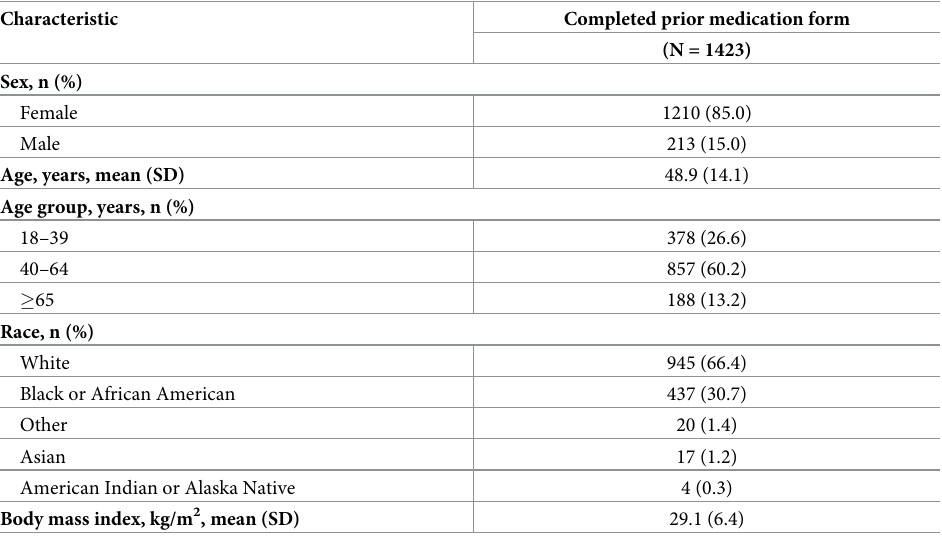
Abbreviations: PMQ = Prior Medication Questionnaire, SD = standard